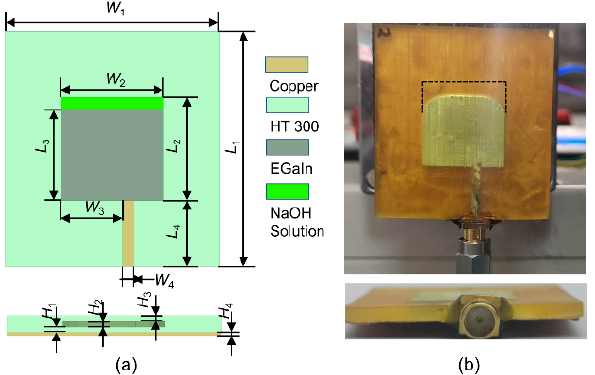
Figure 1. The geometry of the proposed antenna: ( a ) schematic diagram; ( b ) physical diagram. The radiation patch is made of EGaIn (which is a liquid metal with the composition of 75.5% gallium and 24.5% indium, and with an electrical conductivity of σ = 3.46 × 10 6 S/m [33]), and the microstrip line is made of copper (with an electrical conductivity of σ = 5.96 × 10 7 S/m [34]). The positions of the radiation patch and microstrip line are reserved while processing the substrate. The substrate is fabricated by 3D printing with photosensitive resin. To ensure that the hollow structure does not collapse, the radiation patch is covered with a dielectric material with a thickness of 1 mm ( H 1 and H 3 ), and the thickness of the cavity at the center H 2 (i.e., the thickness of the radiation patch and the microstrip line) is set to 0.5 mm. Note that if H 1 and H 3 are too small, the covering layer might be easily collapsed (as shown in Figure S1). The initial value of the patch length L